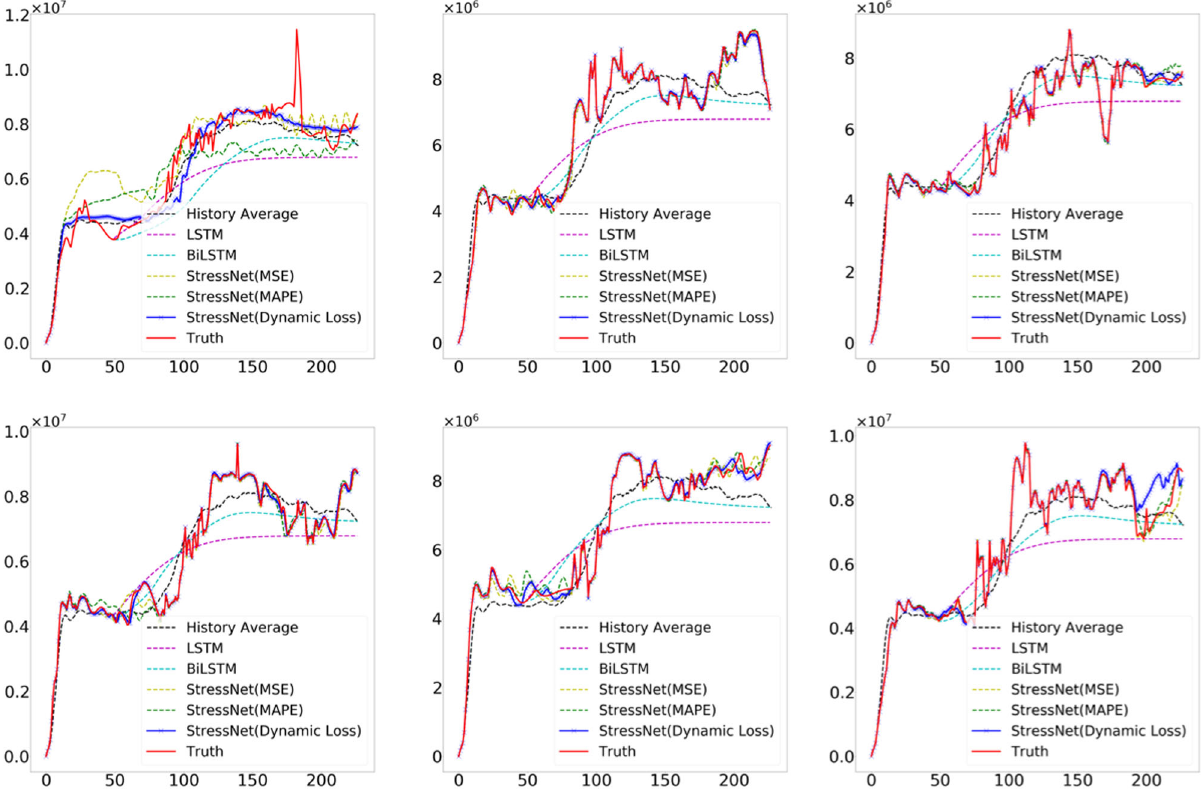
Fig. 3 Comparison of test results on channel xx ( σ xx ) from different models. We use the same training and testing data to train and test each model. From the result, StressNet combined with Dynamic Fusion Loss Function receives the best performance (solid blue